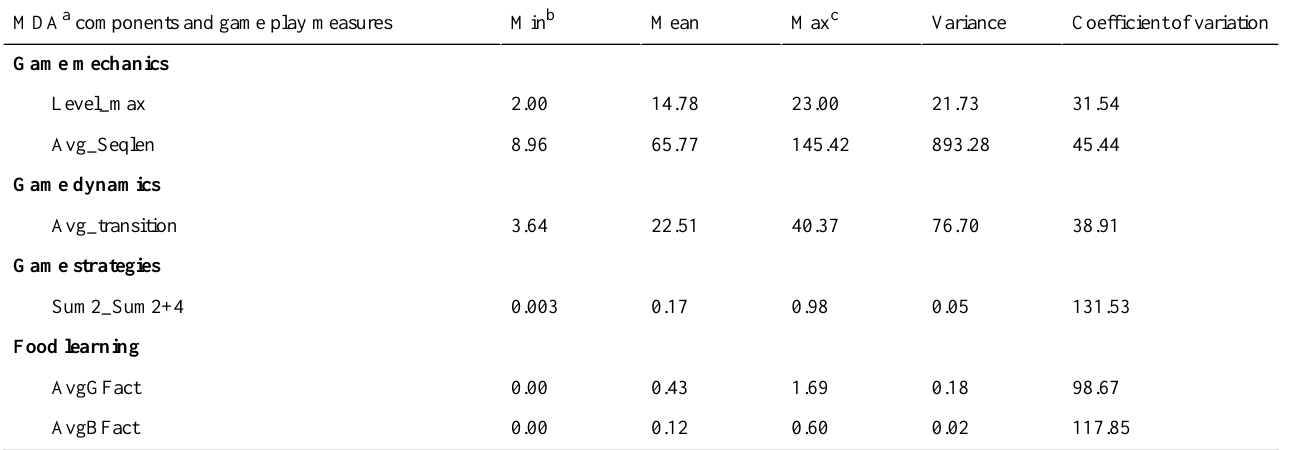
Table 5. Summary statistics of game play measures.